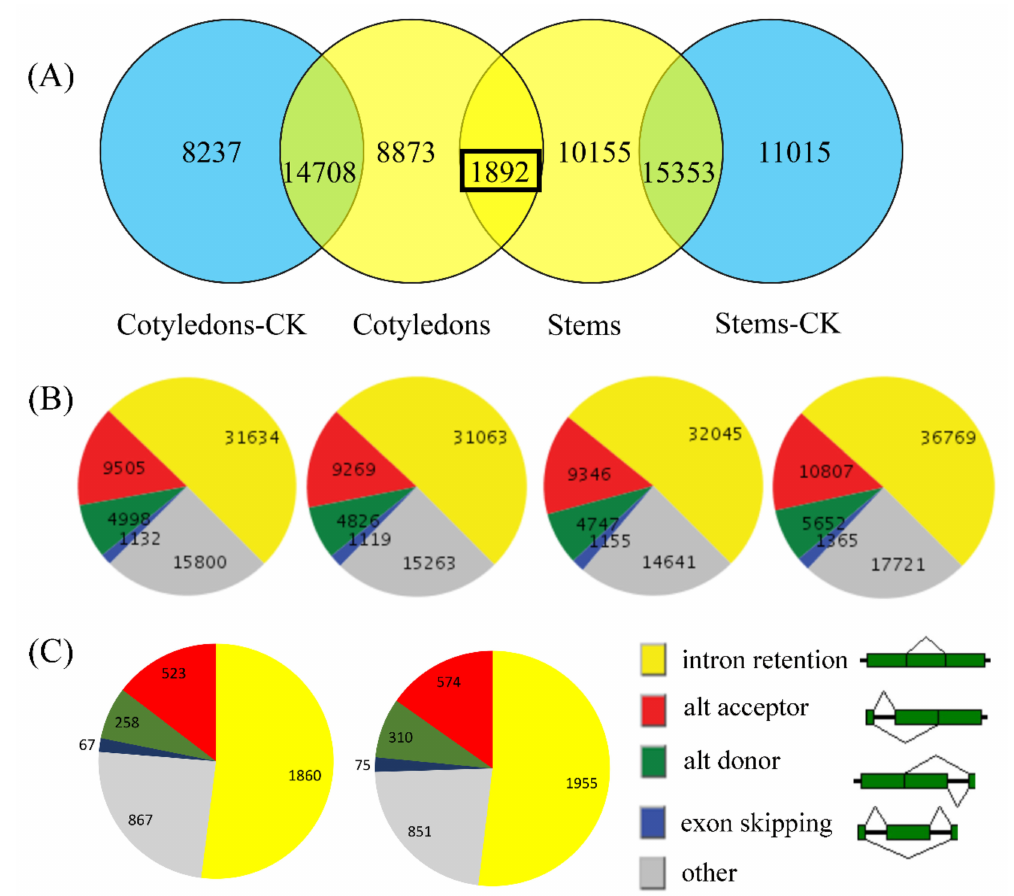
Figure 1. The alternative splicing (AS) landscape of B. napus mock-inoculated and inoculated with L. maculans . ( A ) Genes exhibiting AS in mock-inoculated cotyledons, inoculated cotyledons, inoculated stems, and mock-inoculated stems. All inoculated samples were inoculated with L. maculans . The black rectangle represents the 1892 overlapping genes in inoculated cotyledons and stems. ( B ) The AS patterns of genes in mock-inoculated cotyledons, inoculated cotyledons, inoculated stems, and mock-inoculated stems. ( C ) The AS patterns of the 1892 overlapping genes in inoculated cotyledons and